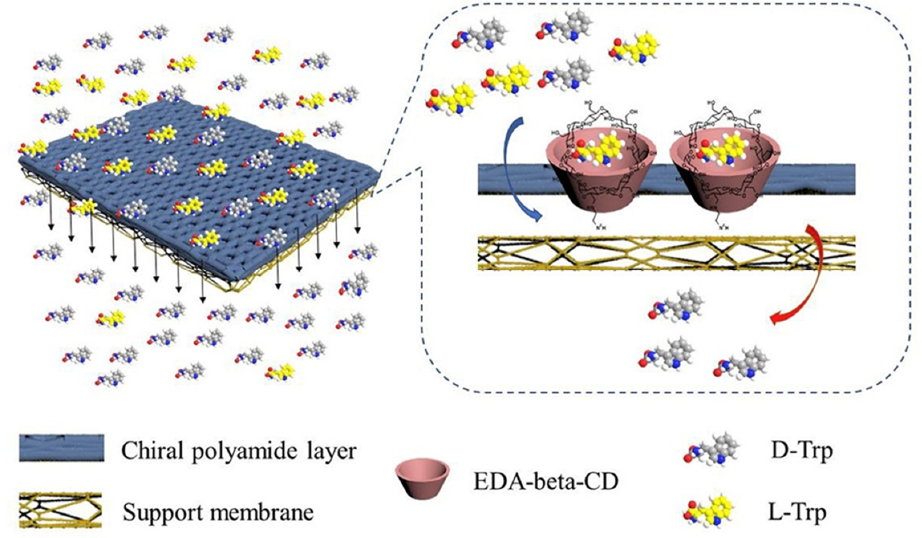
Figure 8. Illustrations of molecular transport mechanisms in the membranes. Reprinted with permission from [44] Copyright 2020 Membrane Science.